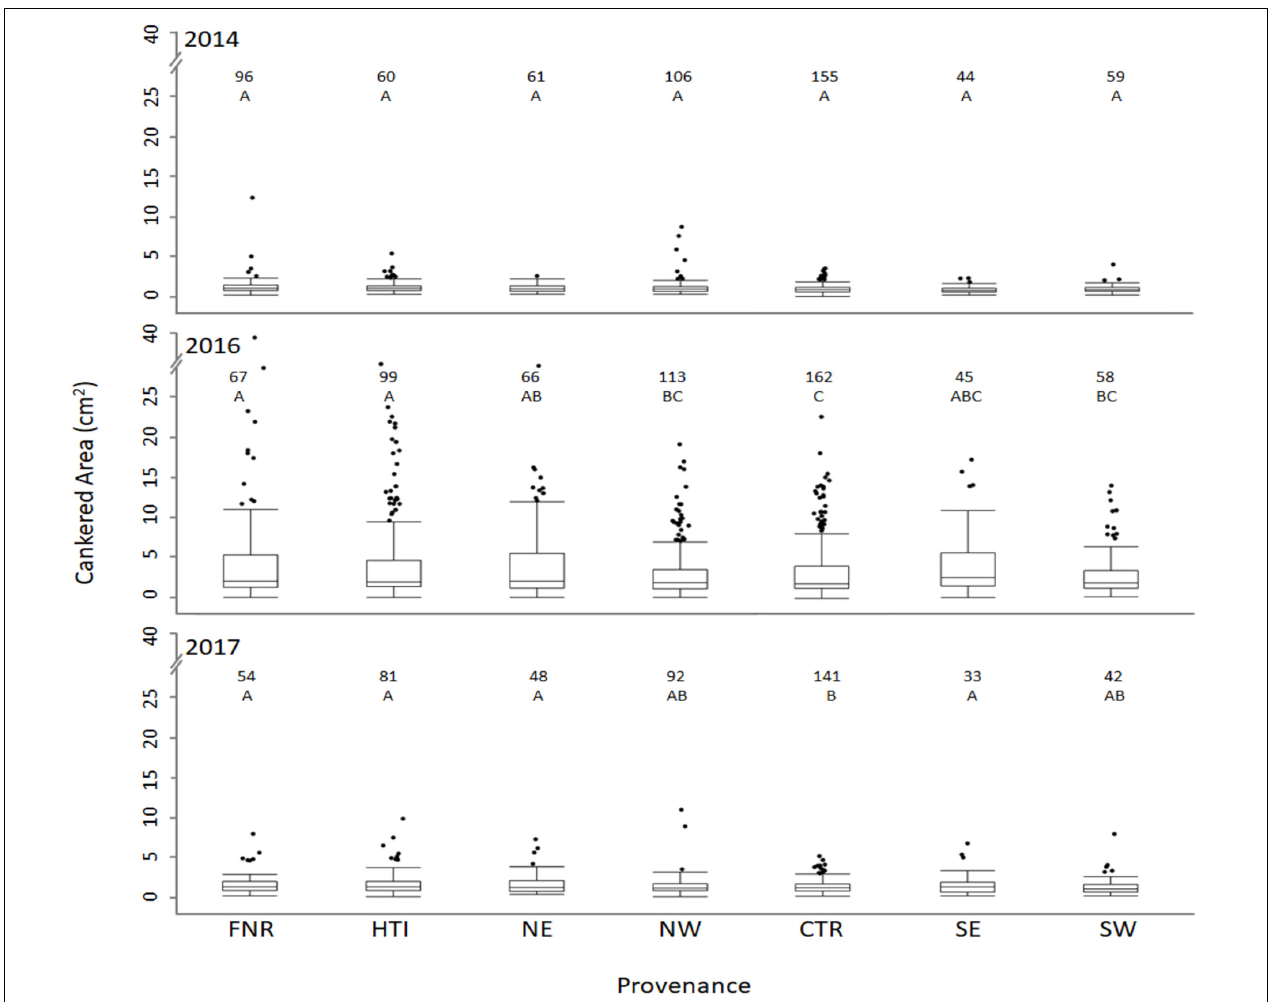
FIGURE 2 | Size of cankered areas (cm 2 ) on Juglans nigra seedlings bred for timber qualities (FNR, HTI) or grown from seed collected from trees that originated from the northeast, northwest, central, southeast, and southwest portion of the native range (NE, NW, CTR, SE, and SW provenances, respectively) planted in a common garden in Fort Collins, CO and inoculated with Geosmithia morbida. The boxes represent the 25th and 75th percentiles, the horizontal line in each box indicates the median. The whiskers signify maximum and minimum values, and circles indicate outliers. Outliers were identified as data points that were outside the 3rd quartile + (1.5 × interquartile range). The numbers above each box plot represent the number of trees tested from the given